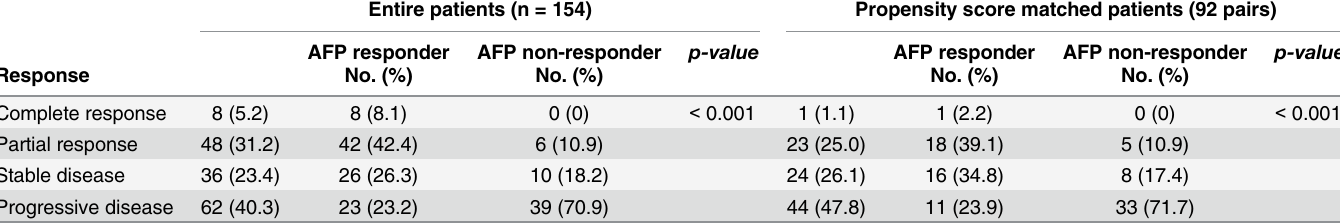
Table 2. Best radiologic responses.